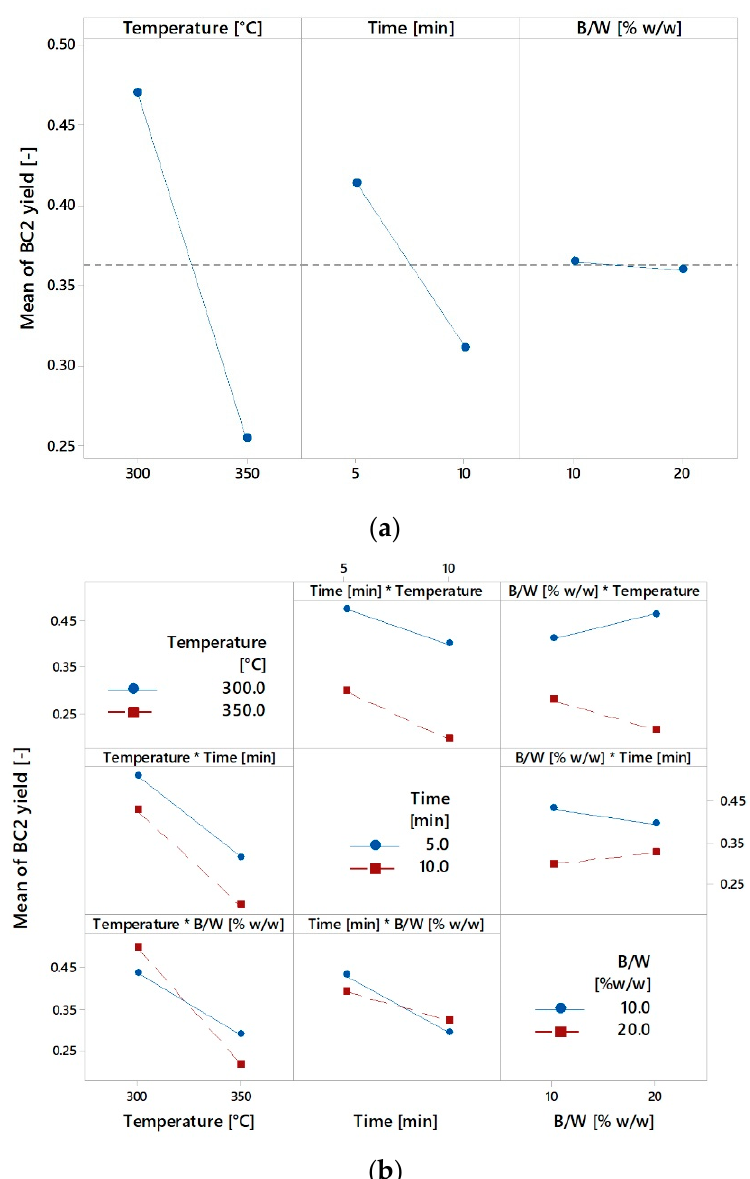
Figure A2. Influence of operating parameters on the yield of biocrude 2: main effects plot ( a ) and interaction effects plot ( b ).